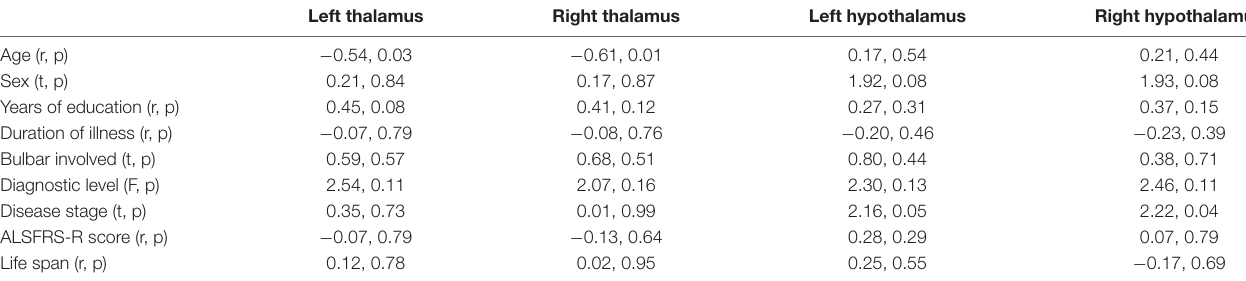
TABLE 2 | Univariate analysis of brain volumes and clinical characteristics. Left thalamus Right thalamus Left hypothalamus